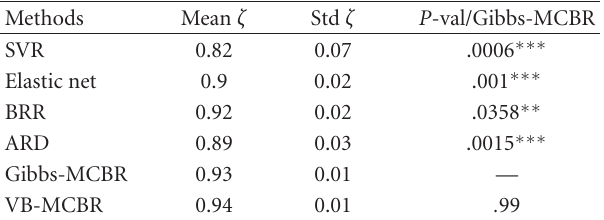
Table 2: Intrasubject analysis . Explained variance ζ for the three di ff erent methods. The P -values are computed using a paired t -test. VB-MCBR yields the best prediction accuracy, while being more stable than the reference methods.